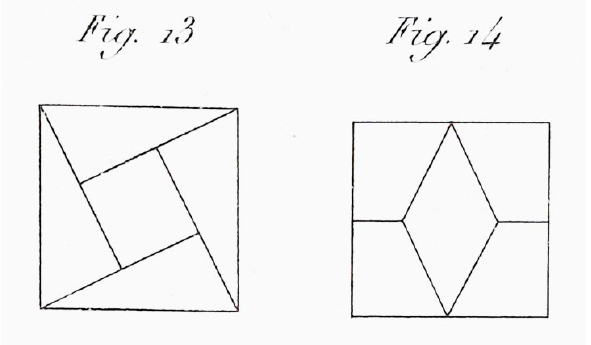
Figure 6. Two sections of a cubic integrant molecule filled with simple molecules. (From the Atlas of reference 14, pl. 69, figs. 13 and